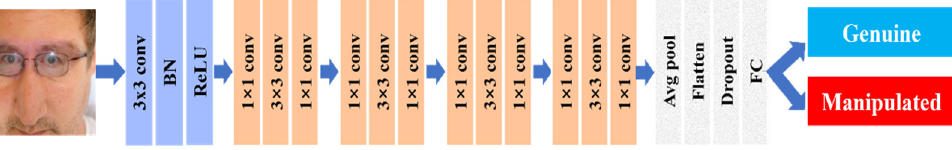
Figure 3. Image generated by various augmentation methods, such as random perspective, color jitter, and rotation.